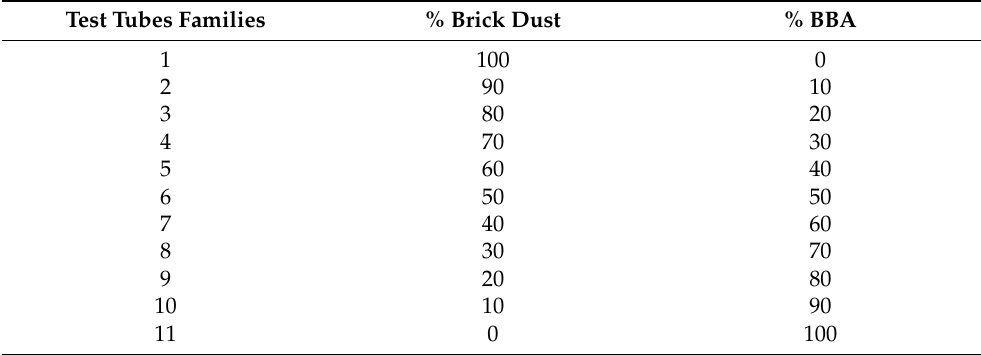
Table 1. Families made up of geopolymers with different percentages of brick dust and biomass bottom